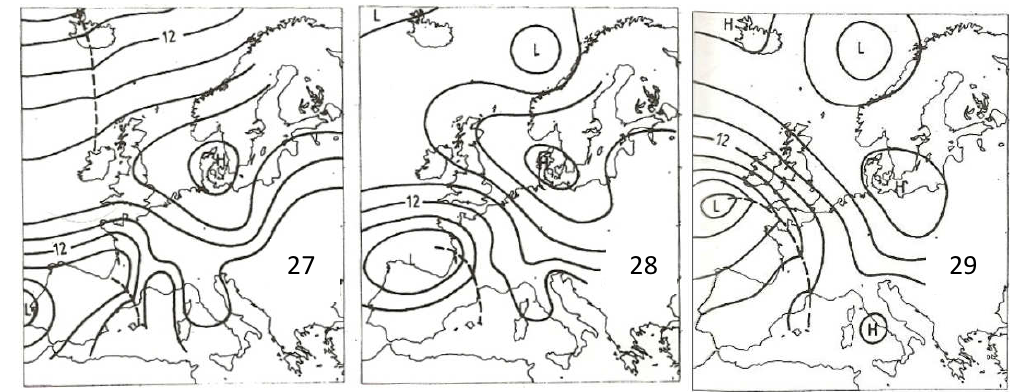
Figure 9. Reconstruction of daily sea level pressure fields in Europe from 27 to 29 Fig. 9. Reconstruction of daily sea level pressure fields in Europe from 27 to 29 December 1784 (Kington, 1988).